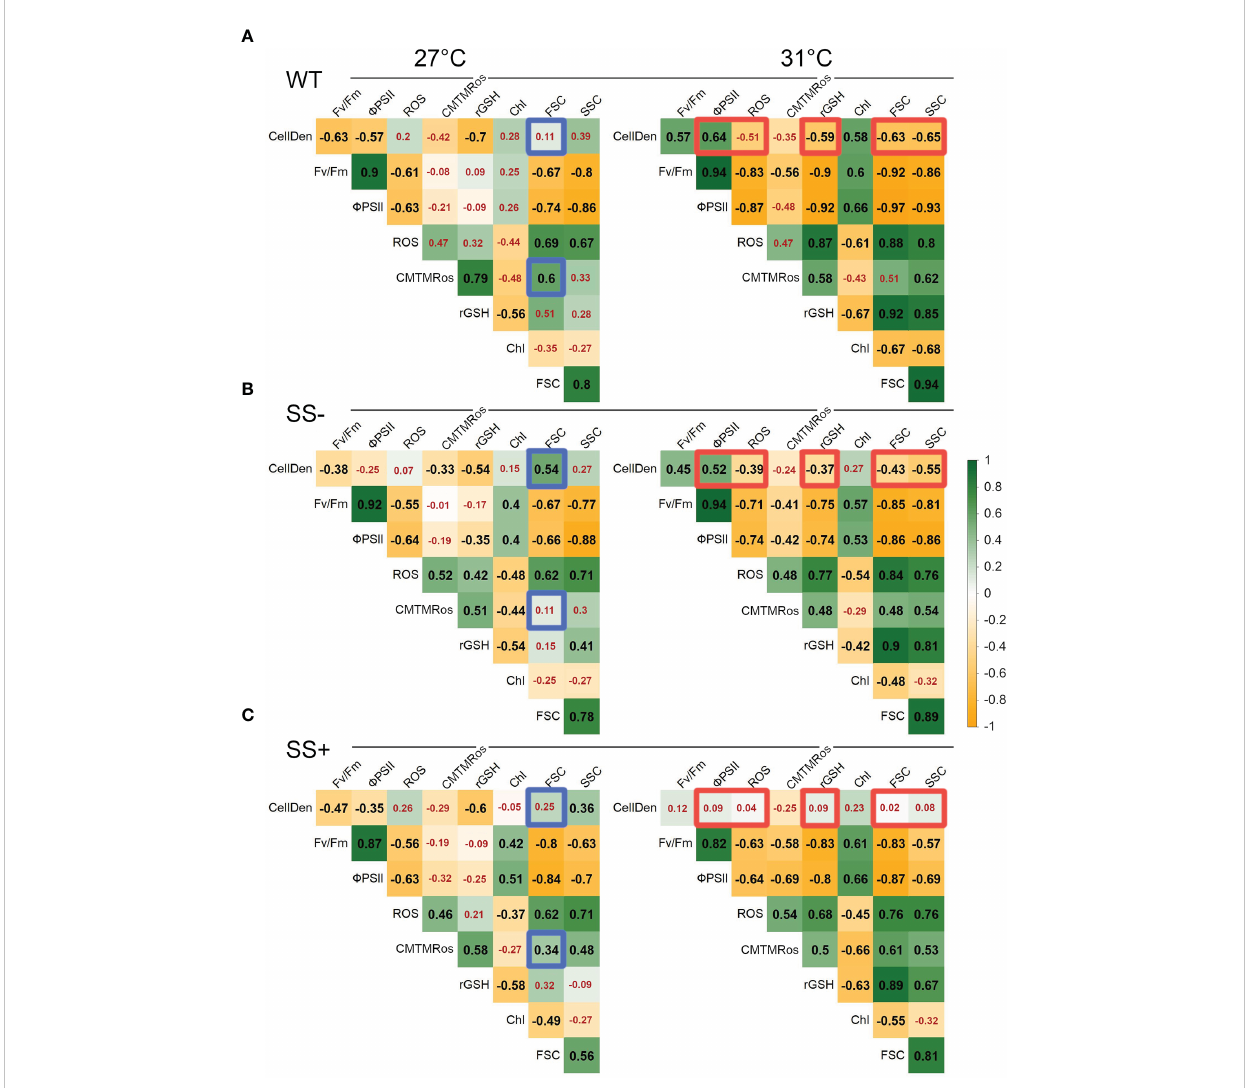
FIGURE 4 Pairwise Pearson correlation coef fi cients (r) between parameters for each strain type and temperature. (A) WT, (B) SS+ and (C) SS-. In order to facilitate visualization of large vs small correlations in each panel, red numbers are used to indicate non-signi fi cant correlations that were above p > 0.05. To highlight major differences between the two temperatures, blue and orange borders indicate r values that differ between strain types by ≥ 0.5 at 27°C and 31°C respectively. Variable abbreviations are as shown in Figure